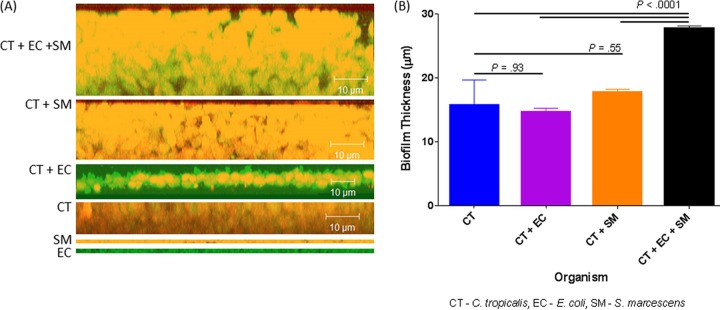
Confocal analysis of biofilms formed by C. tropicalis (CT) alone or in combination with E. coli (EC) and/or S. marcescens (SM). (A) Side view of biofilms formed by C. tropicalis plus E. coli plus S. marcescens, C. tropicalis plus S. marcescens, C. tropicalis plus E. coli, C. tropicalis alone, S. marcescens alone, or E. coli alone. (B) Mean thickness of biofilms.